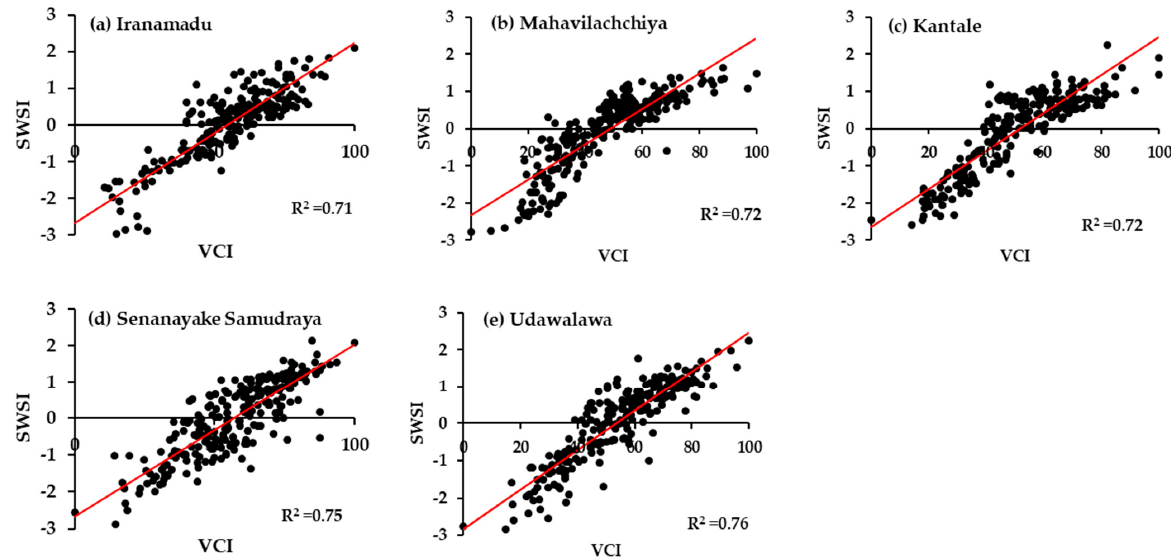
Figure 12. Pearson’s correlation coefficient between VCI and SWSI. ( a )—Tank A (Iranamadu), ( b )—Tank B (Mahavilachchiya), ( c )—Tank C (Kanthale), ( d )—Tank D (Senanayaka Samudraya), ( e )—Tank E (Udavalawa)